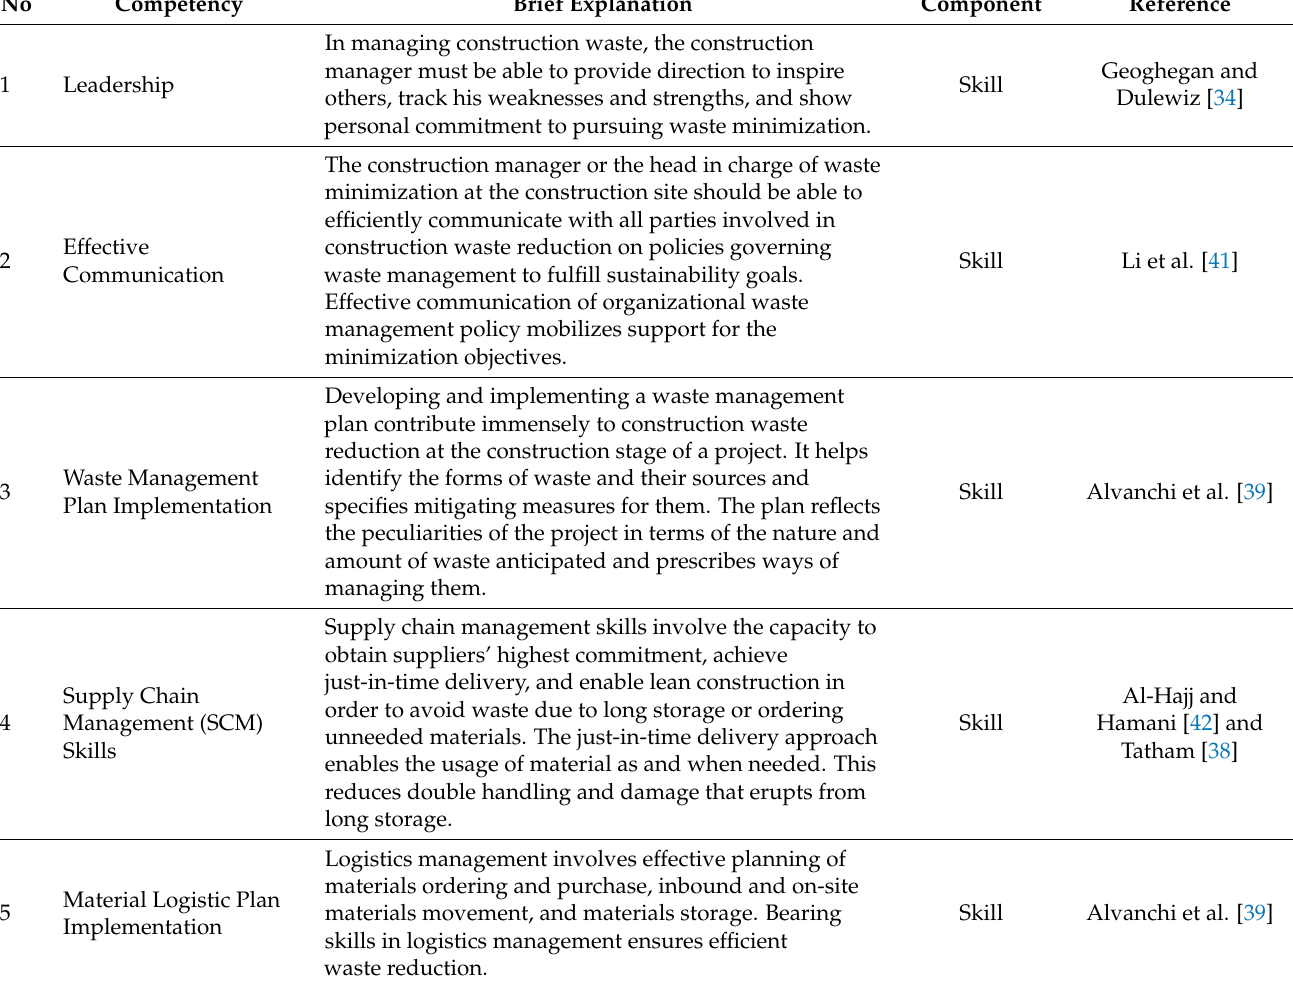
Table 1. Potential Key Competencies that Drive Material Waste